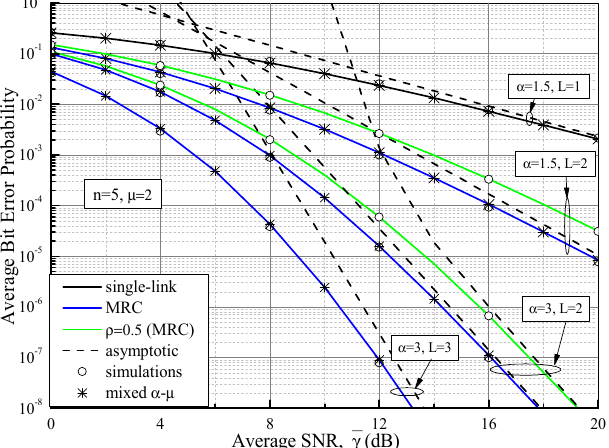
Figure 5. ABEP of DPSK for various communication systems as a function of the average SNR ( 𝛾̅ ) over i.i.d. α - μ /IGA fading channels with n = 5 and μ = 2.